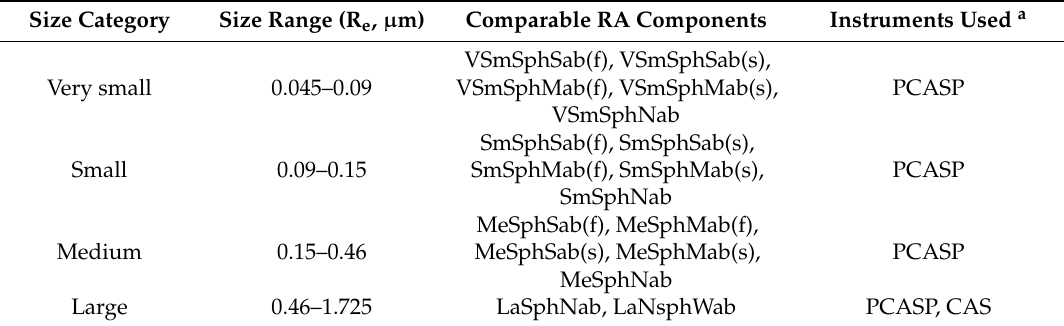
Table 3. Size categories used to analyze the in situ observations. PCASP—Passive Cavity Aerosol Spectrometer; CAS—Cloud and Aerosol